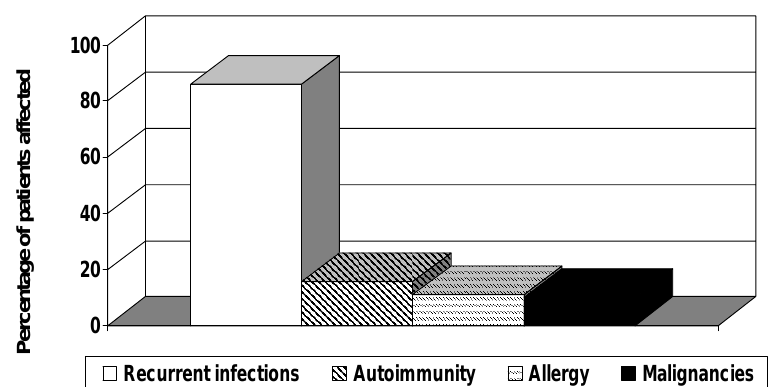
Fig. 2 – Clinical Manifestations of a Brazilian Cohort of CVID patients (n=71) is shown in percentages. The percentage of patients with CVID that manifest specific clinical signs of the disease. Recurrent infections of any nature are the most common feature of CVID, followed by autoimmunity, allergy and